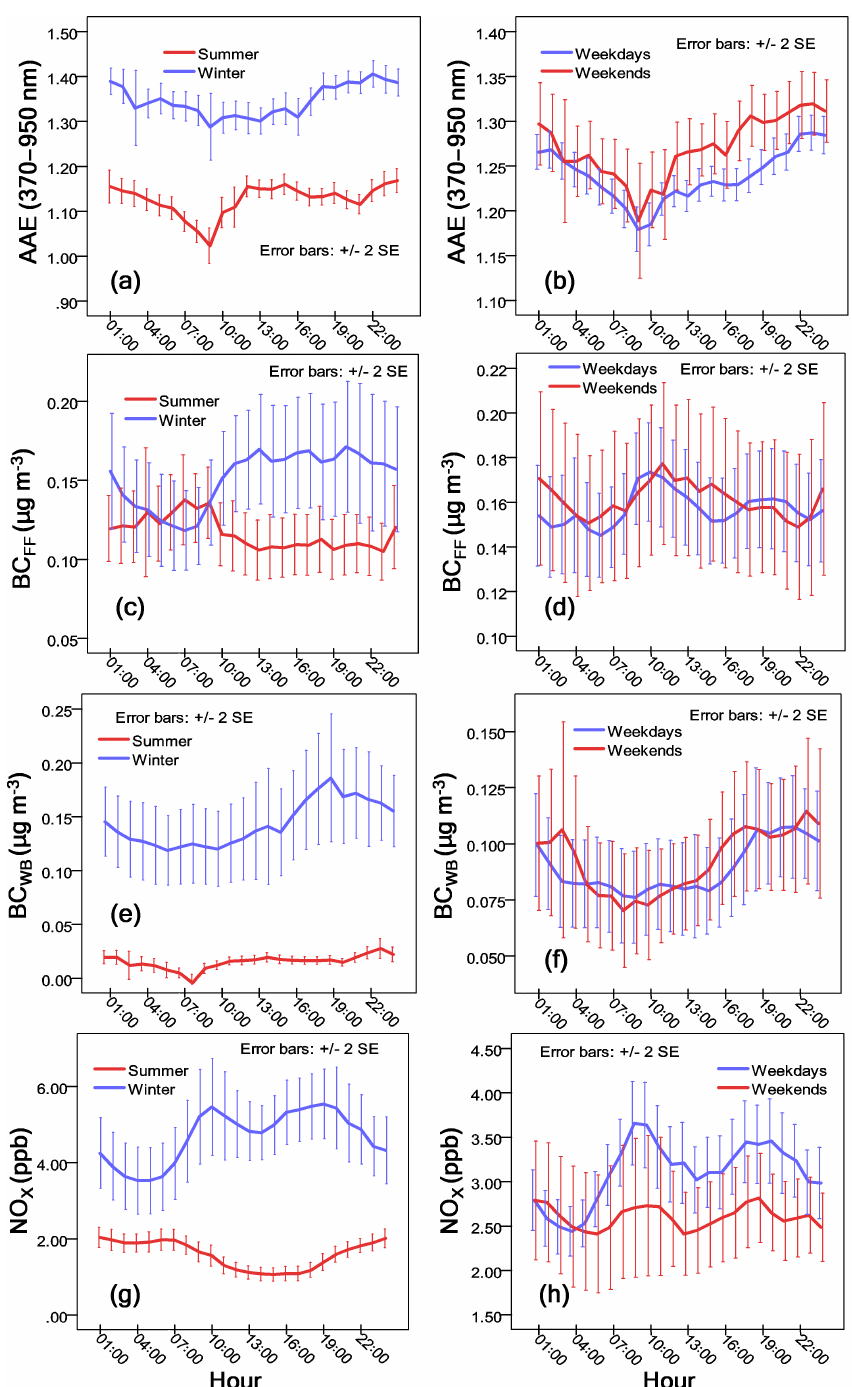
Figure 3. Diurnal variations in AAE (370–950nm, a–b ), BC FF (950nm, c–d ), BC WB (370nm, e–f ) and NO X (g–h) at the Vavihill measure- ment station. Panels (a) , (c) , (e) and (g) represent diurnal differences between summer and winter, while panels (b) , (d) , (f) , and (h) represents diurnal differences between weekdays (Monday–Friday) and weekends (Saturday–Sunday, including national holidays). Uncertainties are given as 2 times the standard error